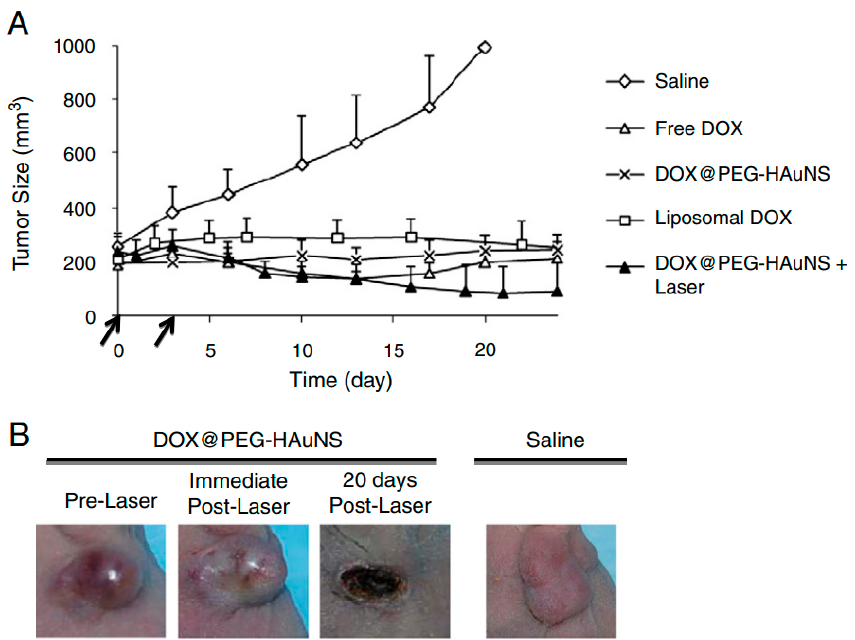
Figure 11. ( A ) Development of tumor size for each treatment depending on the size; ( B ) tumor evolution for doxorubicin (DOX)/Au-NPs with near-infrared (NIR) radiation and without any treatment (Reproduced from [126] with permission from Elsevier, 2021).